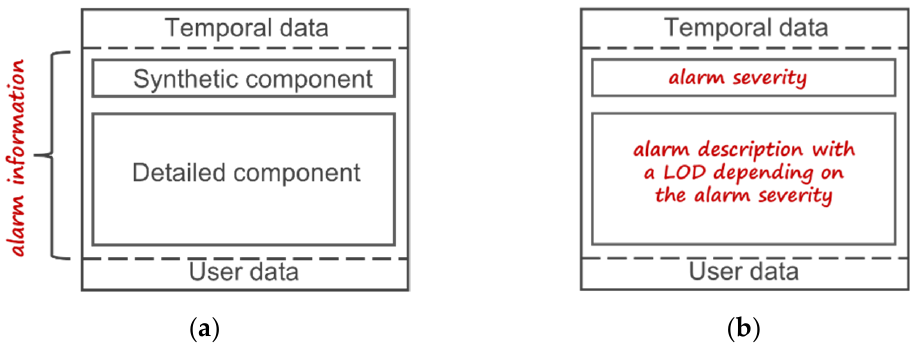
Figure 3. First GLANCE general abstract schema: ( a ) The three components and ( b ) how alarm information is mapped onto the synthetic and detailed component. Table 4. Level-Of-Detail (LOD) defined as association between severity level and schema attributes.